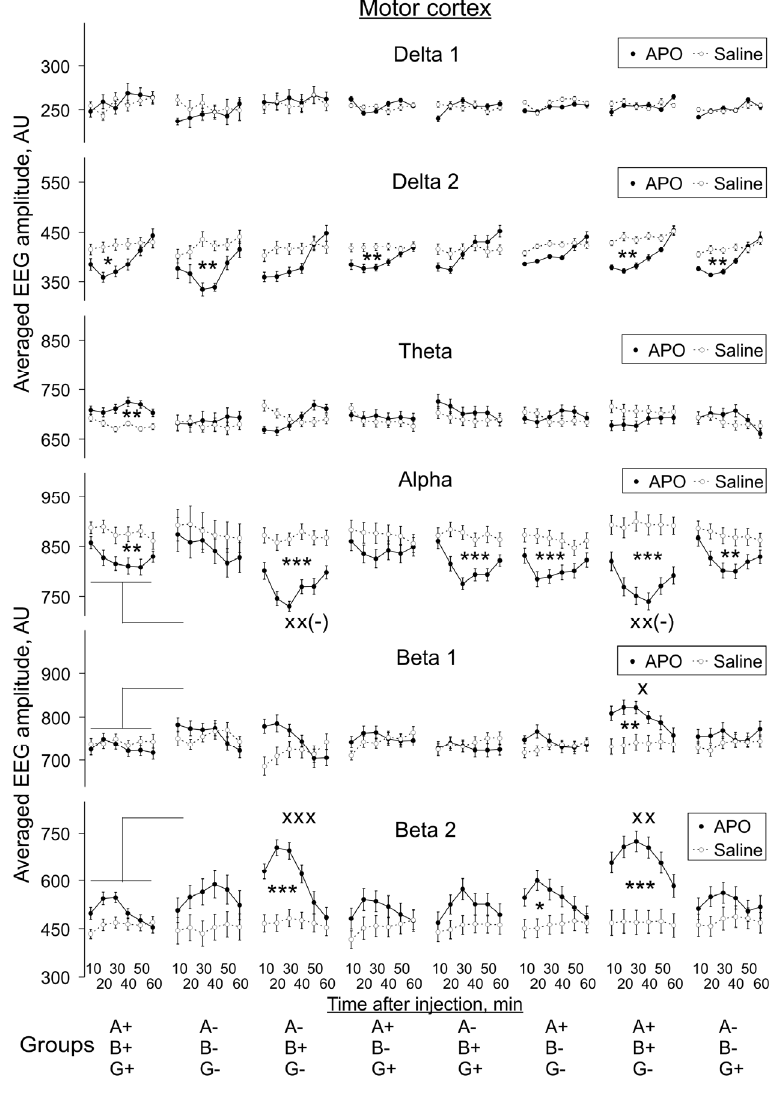
Figure 5. The evolution of apomorphine (APO, 1.0 mg/kg, s.c.) vs. saline effects in “classical” frequency bands of 12 s fragments of EEG from the motor cortex averaged for consecutive 10 min intervals (abscissa) in knockout mice of different types denoted on the horizontal axes. Ordinate is the averaged absolute values of EEG amplitudes in each of the “classical” bands, in arbitrary units (vertical lines are ± 1 SEM), obtained in experiments with saline and APO (grey and black lines, respectively) in each group. Differences between baseline EEGs in knockout and wild-type mice were used to normalise APO effects in knockout groups to those in control. Symbols * and x denote significant differences in APO vs. saline and knockout mice vs. wild-type control, respectively (one, two and three symbols denote p < 0.05, <0.01 and 0.001, respectively). Symbol x(-) denotes the significant enhancement of the APO suppressive effect, for clarity.